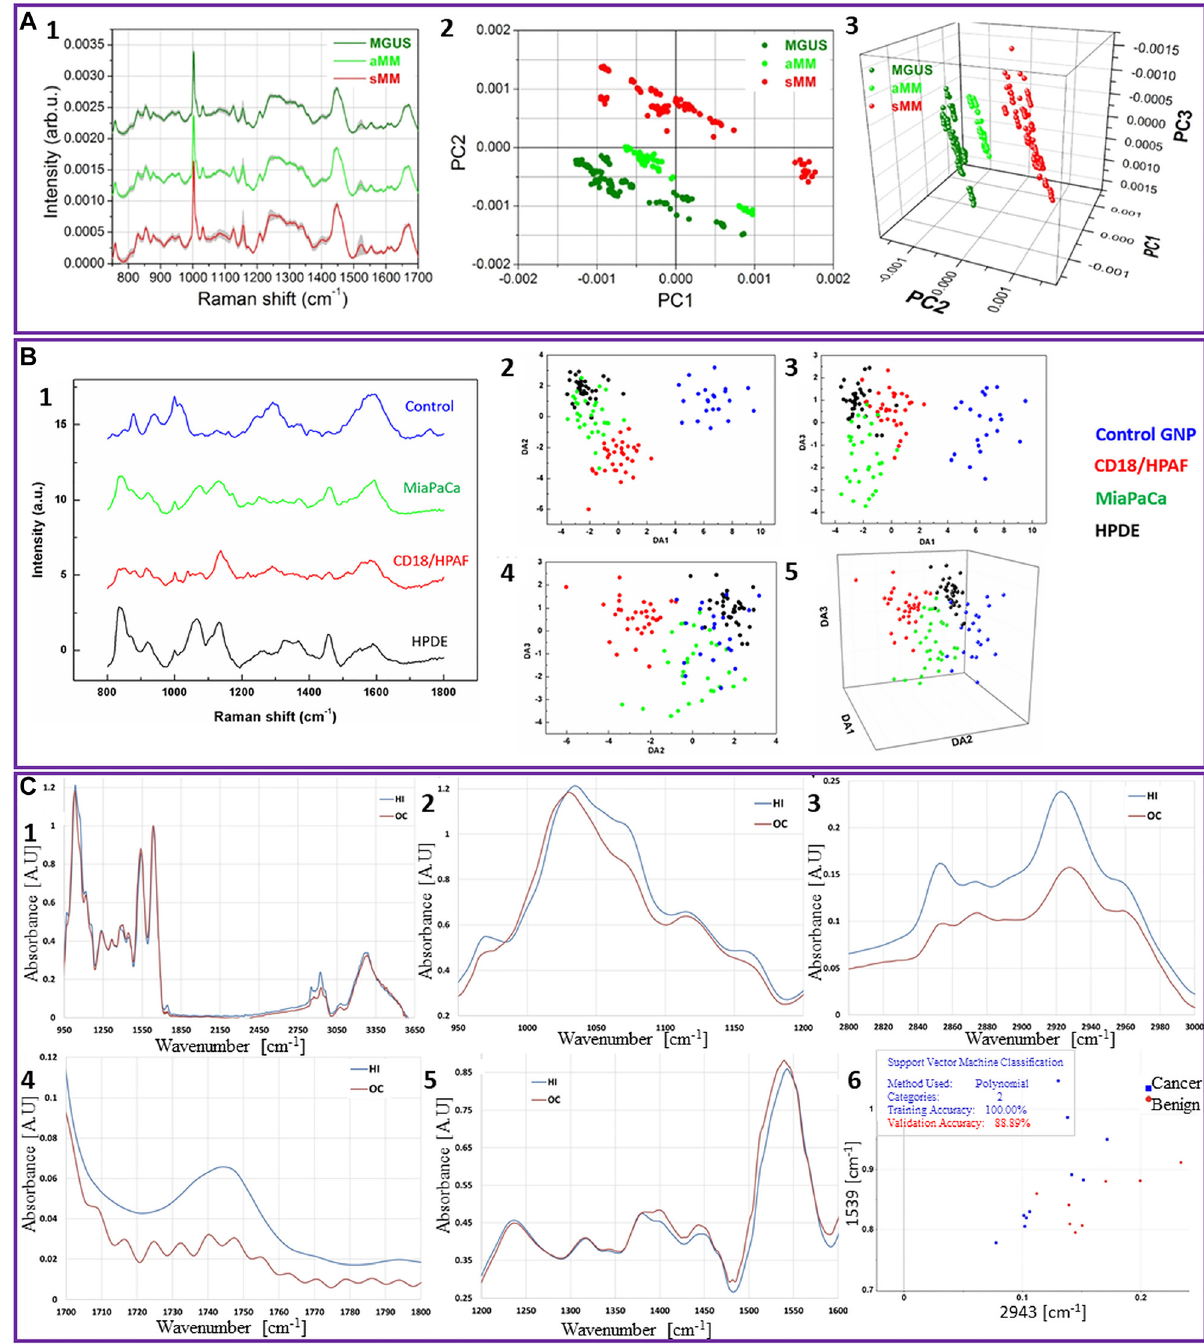
Figure 7: Application of label-free optical methods for characterization of EVs isolated from cancer patients. (A) Raman spectra recorded from EVs isolated from multiple myeloma patients and their PCA analysis; (A1) Average Raman spectra collected fromEVsisolatedfrompatientswithdifferentstagesofmultiplemyeloma;(A2)PCAanalysisshowsthestratificationofEVsbasedonthestage of multiplemyeloma patients;(A3) 3D scatter plot of PCA analysis(adaptedwith permissionfrom [254]). (B)SERSspectra of EVs and their PCA and DFA analysis used for the early detection of pancreatic cancer; (B1) SERS spectra of EVs from both normal human pancreatic ductal epithelial cell line (HPDE) and pancreatic cancer cell lines (CD18/HPAF, MiaPaCA); (B2) – (B5) Scatter plots of the discriminant function classi fi ers DAs showing the capability of the PC-DFA algorithm to differentiate different EVs subpopulations; (B2) Scatter plot of DA1 versus DA2; (B3) Scatter plot of DA1 versus DA3; (B4) Scatter plot of DA2 versus DA3; (B5) Scatter plot of DA1 versus DA2 versus DA3 (reproduced with permission [256]). (C) Label-free FTIR EVs analysis used in the diagnosis of oral cancer. Average IR absorbance spectra of the oral cancer patientsandhealthyindividualsEVsintherangeof:(C1)950 – 3650cm − 1 ;(C2)950 – 1200cm − 1 ;(C3)1200 – 1600cm − 1 ;(C4)1700 – 1800cm − 1 ;(C5) 2800 – 3000 cm − 1 ; (C6) Support vector machine classi fi cation results clearly separate cancer and benign originating EVs (adapted with permission from